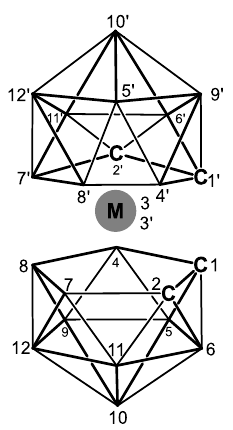
Figure 1. Structure and atom numbering of 3-metal-bis(1,2-dicarbollide) ate [M(C 2 B 9 H 11 ) 2 ] − . M = Co, Fe, Ni, Cr, Re, Al, Au, Ir, Mn, Pt, etc. Hydrogen atoms of C–H groups and B–H groups of the boron clusters, symbolized by the polygen vertex, were omitted for the clarity.